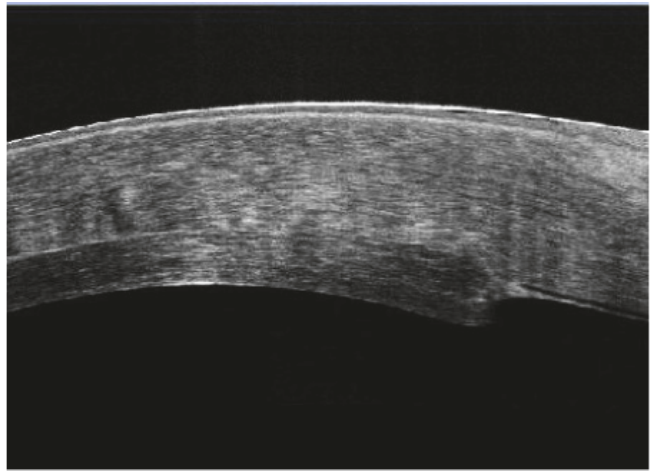
Figure 9: Severe disparity between the posterior graft and the posterior corneal defect one month